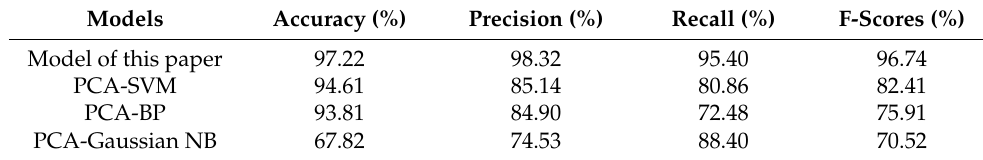
Table 7. Comparison of model